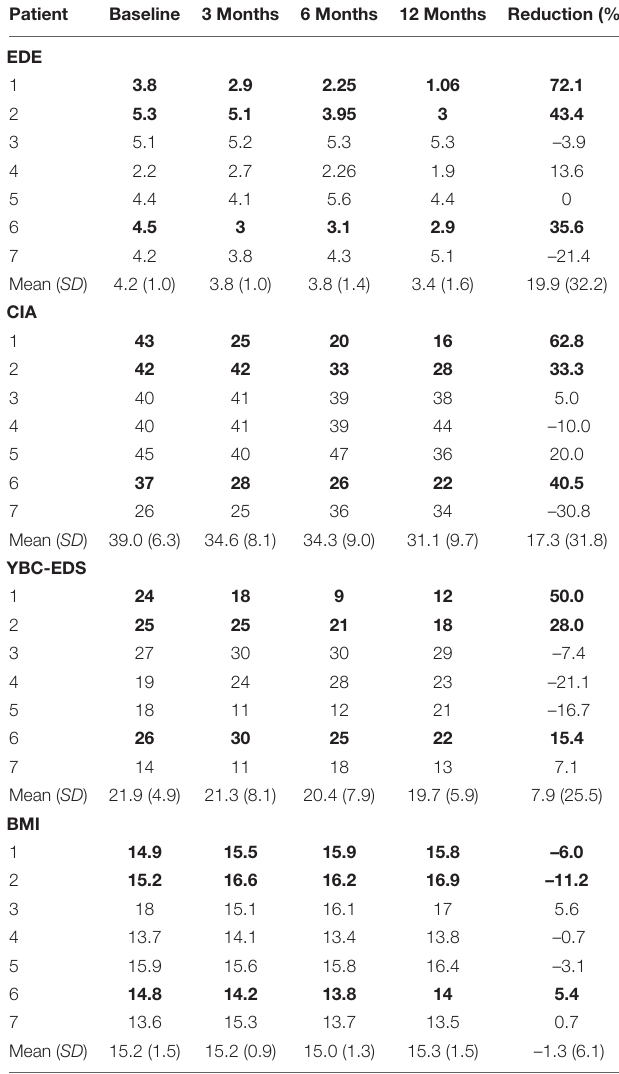
TABLE 3 | Eating disorder psychopathology scores: EDE, Eating Disorder Examination; CIA, Clinical Impairment Assessment; YBC-EDS, Yale-Brown-Cornell Eating Disorder Scale; BMI, Body Mass